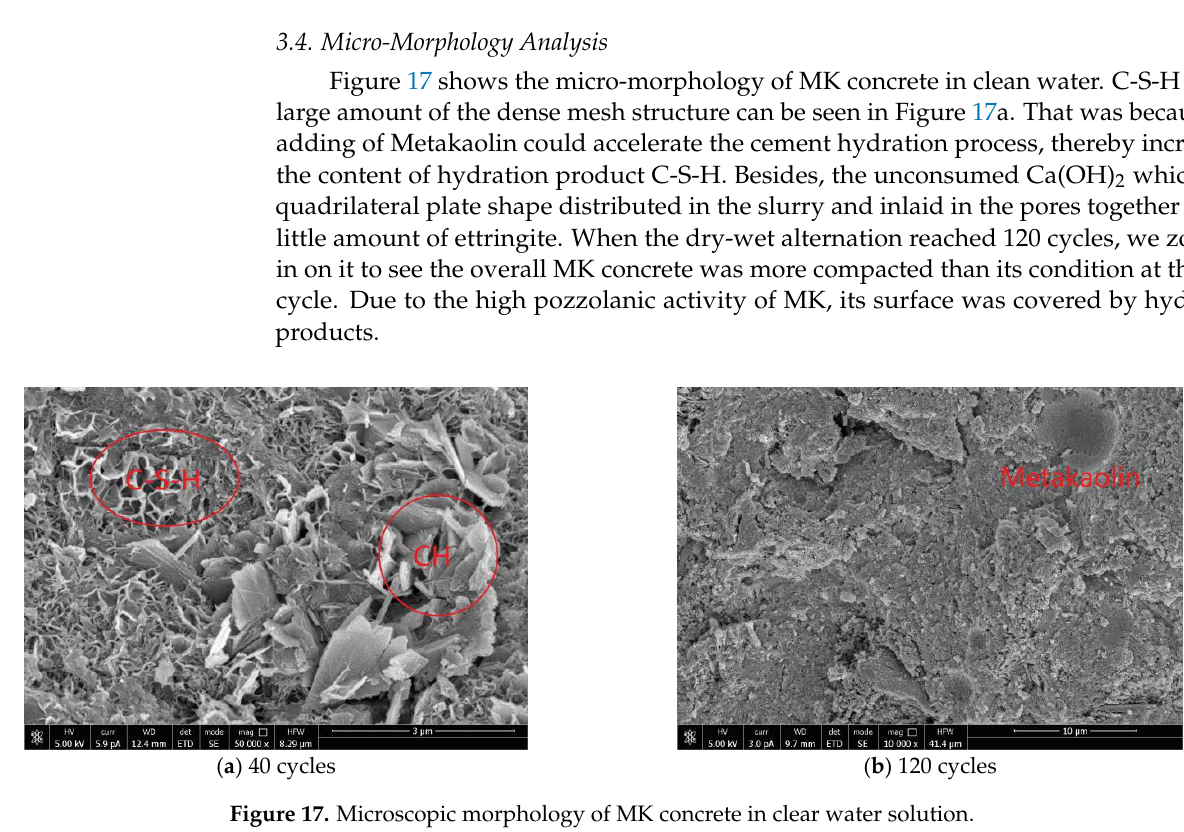
( b ) Dry-wet cycle 40 times Figure 16. FTIR spectra of concrete corroded by Mg 2+ solution. 3.4. Micro-Morphology Analysis Figure 17 shows the micro-morphology of MK concrete in clean water. C-S-H with a large amount of the dense mesh structure can be seen in Figure 17a. That was because the